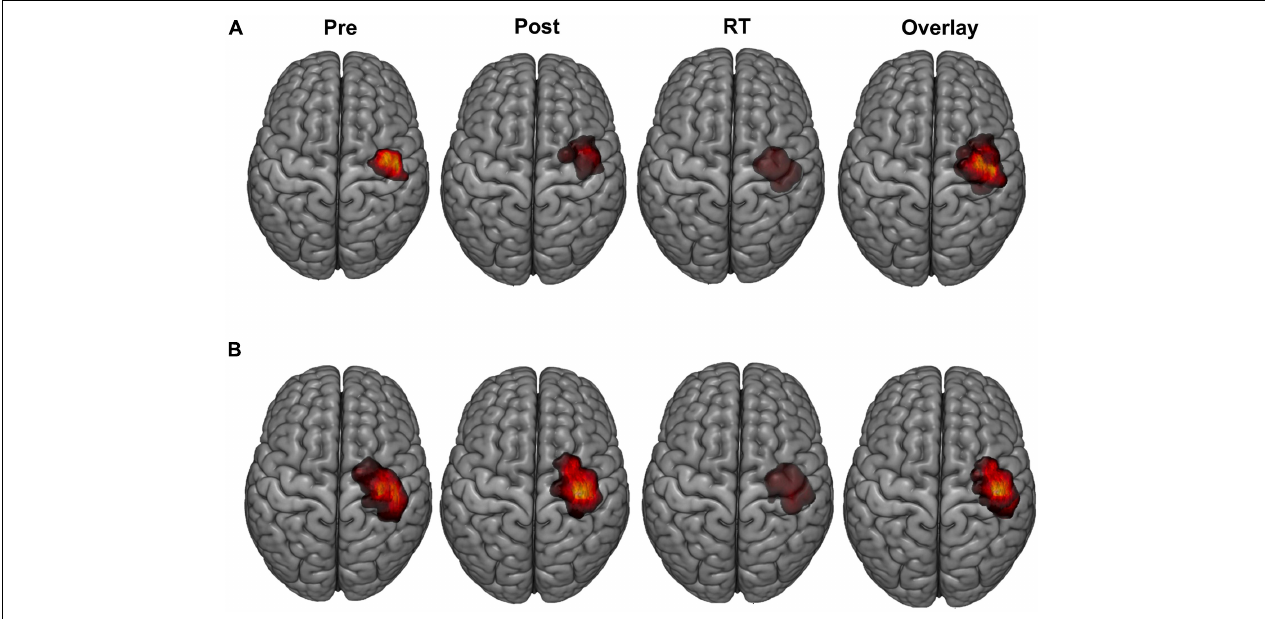
FIGURE 2 | LFDI motor maps. Representative single subject examples of LFDI motor map across robotic TMS motor mapping sessions (pre, post, RT) and all three time points overlaid on a three-dimensional (3D) curvilinear brain from a Sham participant (A) and a participant in the tDCS group (B) . Pre = baseline; Post = day 5; RT = six-weeks retention time; LFDI = left-hand first dorsal interosseous